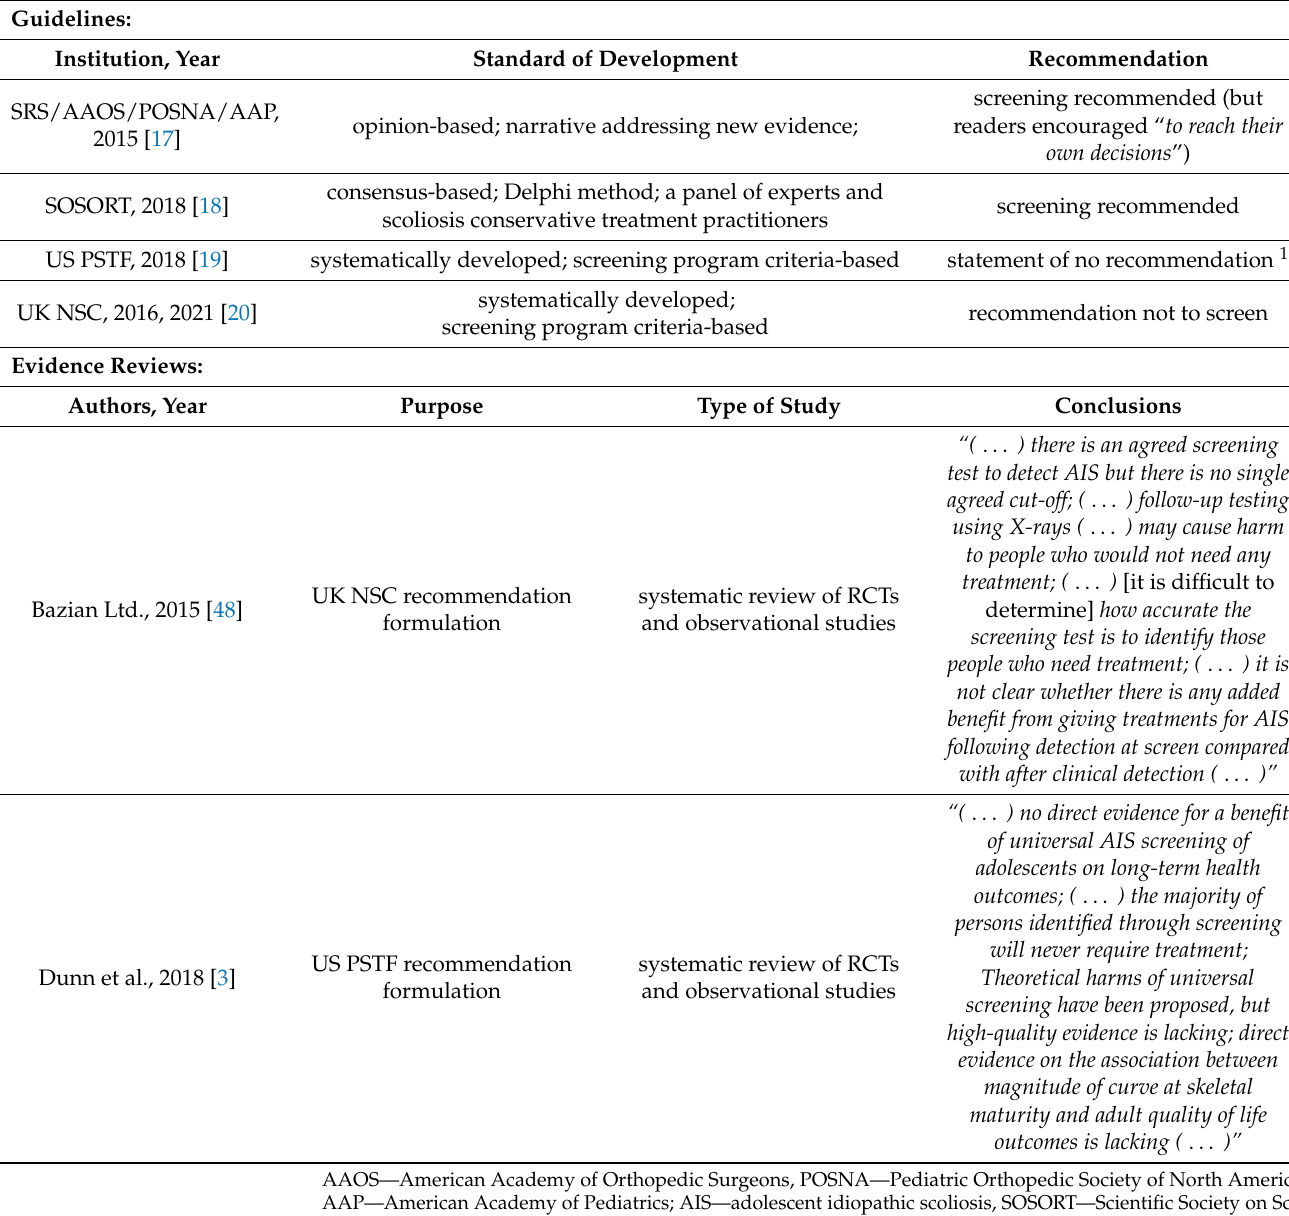
Table 1. Characteristics of the included guidelines and reviews of